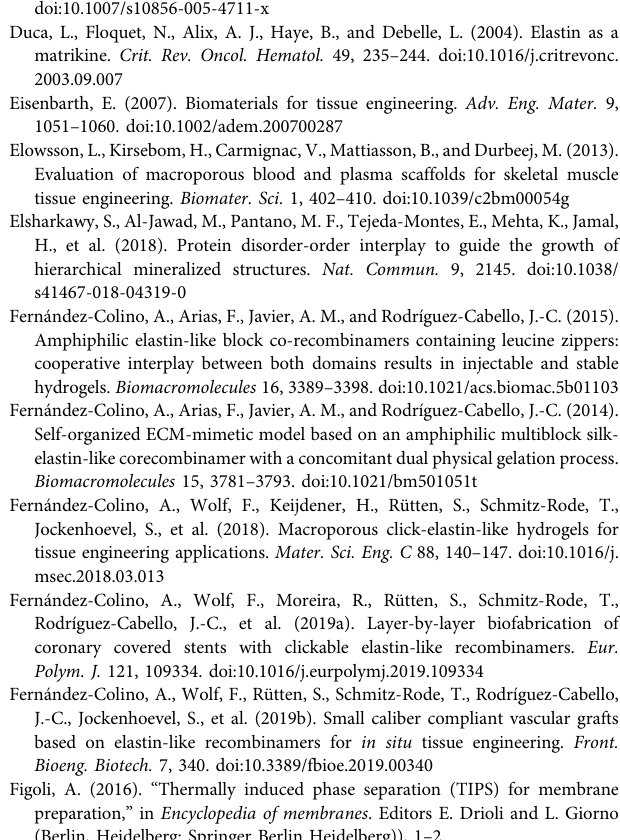
Figoli, A. (2016). “ Thermally induced phase separation (TIPS) for membrane preparation, ” in Encyclopedia of membranes . Editors E. Drioli and L. Giorno (Berlin, Heidelberg: Springer Berlin Heidelberg)), 1 –